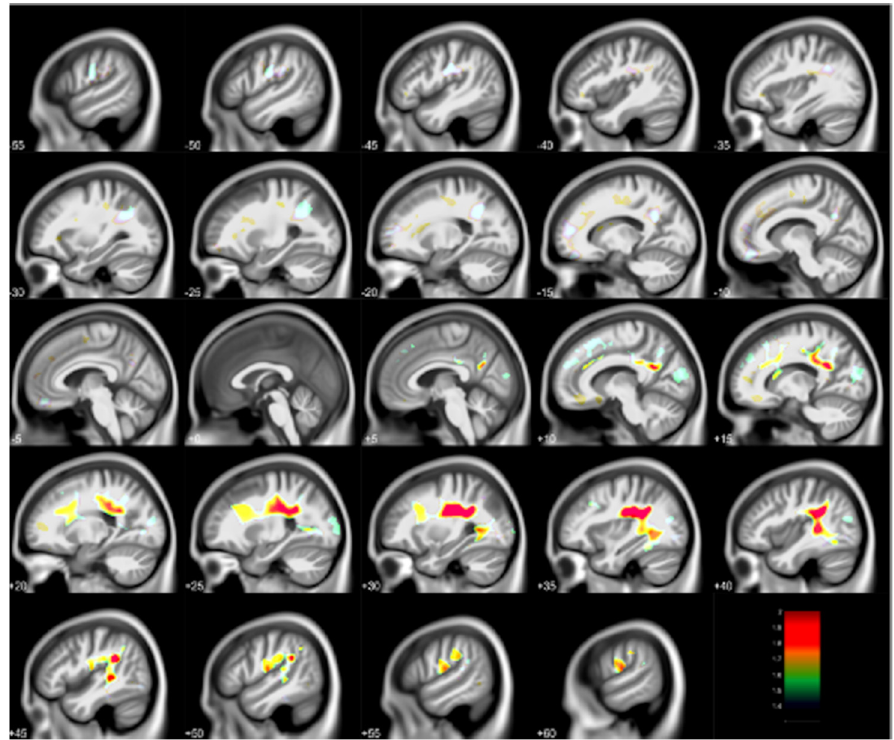
Figure 3. Regional white matter volume loss inversely associated with childhood blood lead concentra- tions obtained at age 78 months with covariates from the Cincinnati Lead Study. The population imaged includes 123 adults ages 27–33 years imaged at 3 Tesla. Clusters were corrected for multiple comparisons (FWE = 0.05) using threshold free cluster enhancement. Negative slice numbers = left hemisphere, positive slice numbers = right hemisphere. Color bar represents − log( p ) value from 1.4 to